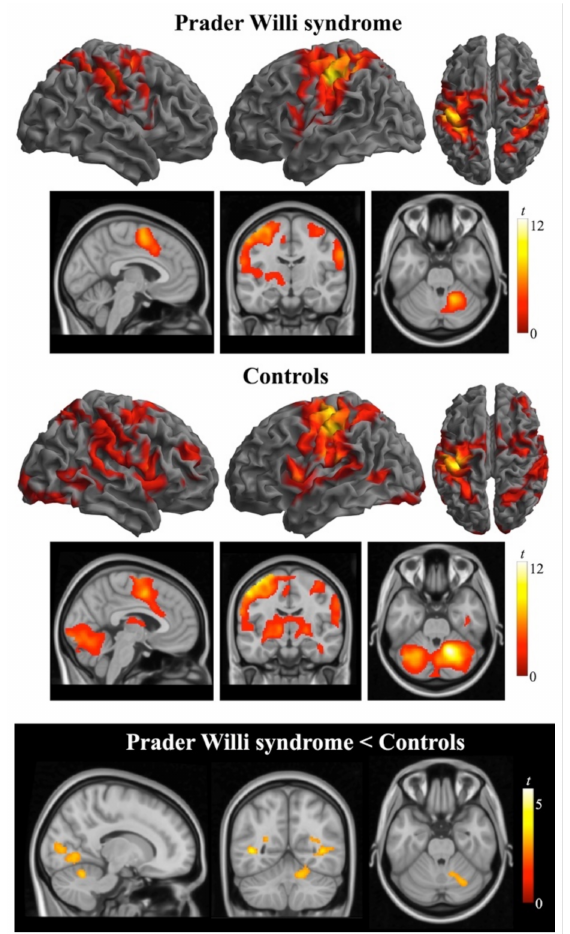
Figure 3. Brain activation obtained during the fingers-to-thumb opposition task in individuals with Prader Willi syndrome (top rows) and control subjects (mid rows). The brain views in the bottom row illustrate between-group differences in whole brain activation. Activations are thresholded at p FWE -corrected < 0.05. Color bars represent t values. Right in axial and coronal views corresponds to the right